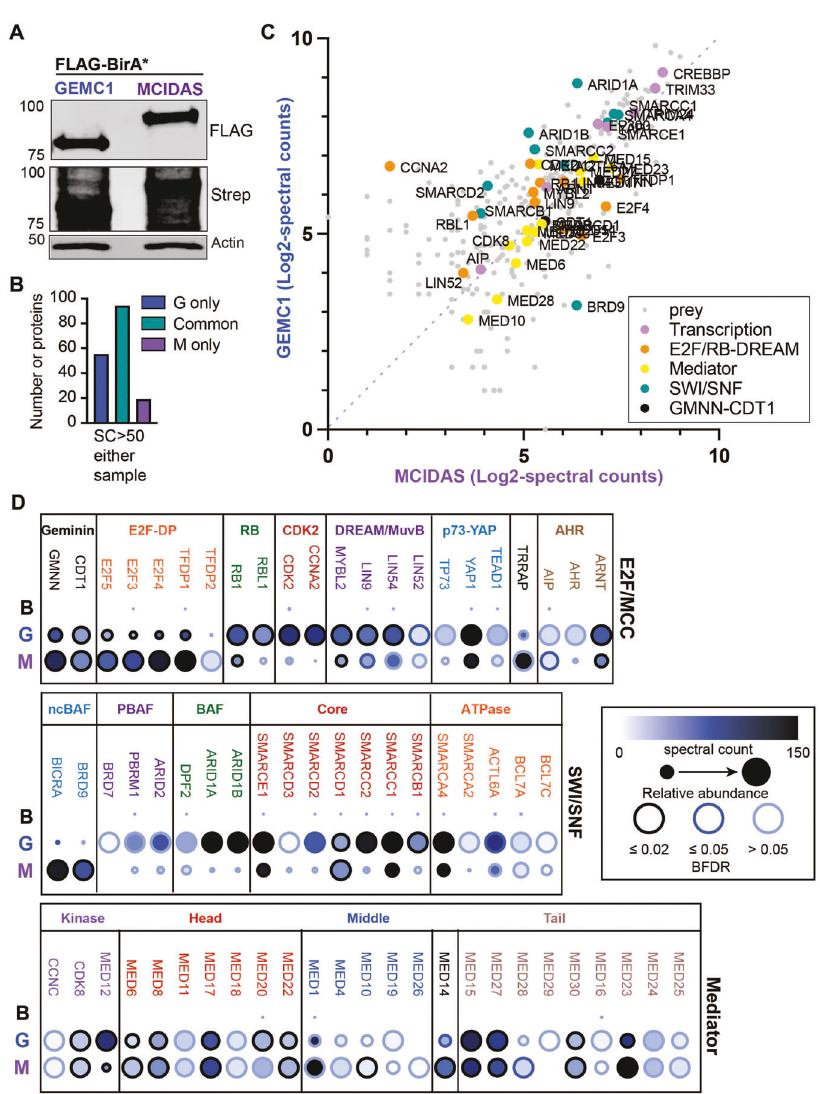
Fig. 2 The proximal interactomes of GEMC1 and MCIDAS. A Western blots from lysates of AD-293 cells transfected with FLAG-BirA*, FLAG- BirA*-GEMC1 or FLAG-BirA*-MCIDAS. Expression of baits in cells with or without biotin supplementation is shown using the FLAG antibody (bottom panel) and labeling in biotin supplemented samples with Strep-HRP (top panel). B Graph of protein number unique or common to each sample using a cutoff >50 spectral counts (SC) with a BFDR score of <0.05 in either one of the samples ( n = 3 biological replicates). C Scatter plot of peptides identi fi ed in GEMC1 or MCIDAS samples (Log2- spectral counts of 3 biological replicates). All peptides with BFDR < 0.05 in one of the samples from analysis with SAINTexpress are shown (Full list in Supplementary Table S4) [22]. Speci fi c subsets are highlighted including key Transcription, components of the E2F/RB or DREAM complexes, SWI/SNF and Mediator related proteins. D Dot plot depicting relative abundance and spectral counts for selected proteins. B = BirA*, G = GEMC1, and M = MCIDAS. Proteins are grouped by those involved in E2F or MCC differentiation (top row), components of SW/SNF complexes (middle row) and components of the Mediator complex (bottom